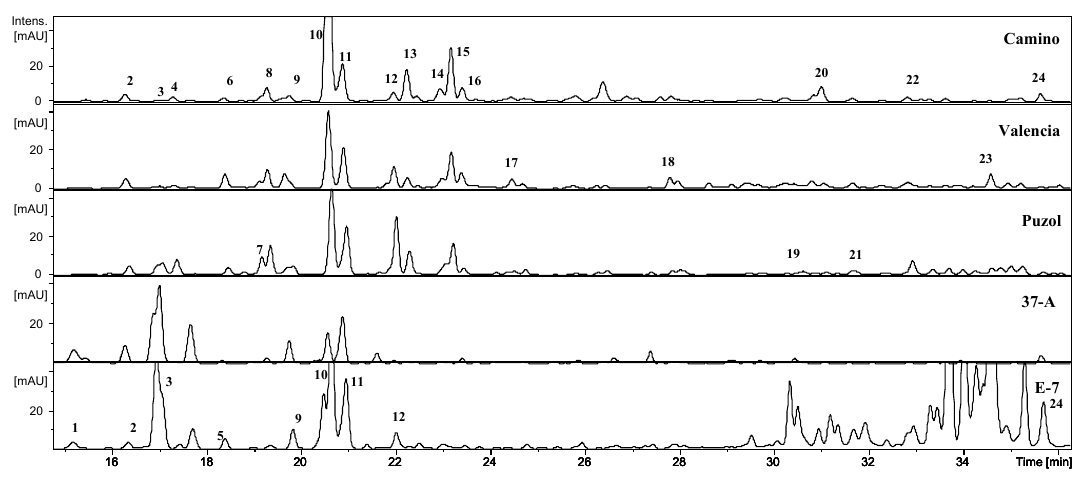
Figure 1. Chromatogram obtained from reversed-phase LC-MS/MS analysis of pepino varieties. Numbers in bold correspond to the peaks identified and described in Tables 2 and 3.